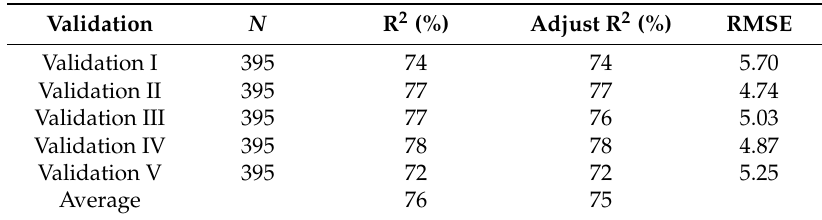
Table 5. Cross-validation results for hourly average indoor PM 2.5 concentration.